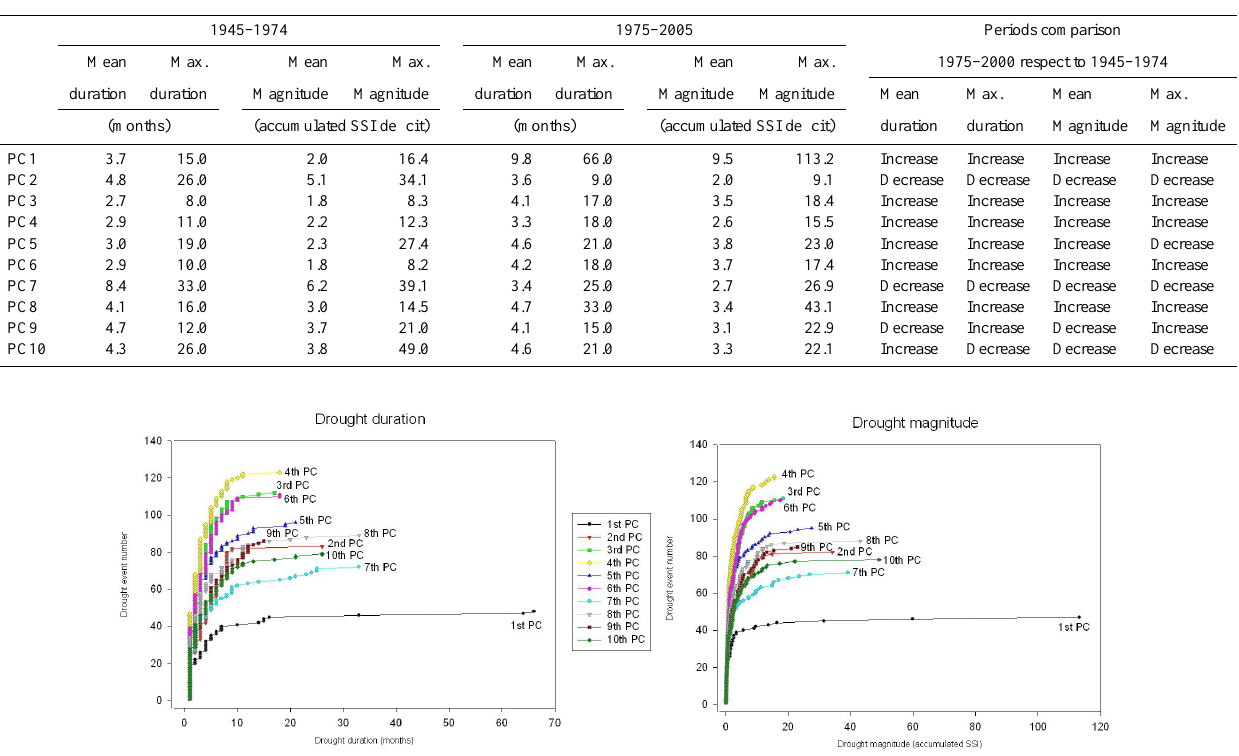
Table 1. Streamflow drought duration and accumulated deficits for two contrasted periods (1945–1974 and 1975–2005) for each principal component.